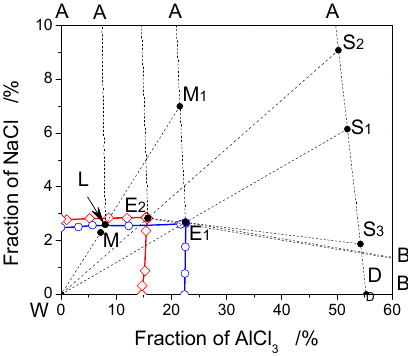
Figure 2. The part of the phase diagram of the NaCl-AlCl 3 -H 2 O system at 353.15 K. A—NaCl, B—AlCl 3 , W—(HCl+H 2 O), D—AlCl 3 ·6H 2 O; ○ —H + = 1.3 mol/L, ◊ —H + = 4.0 mol/L.